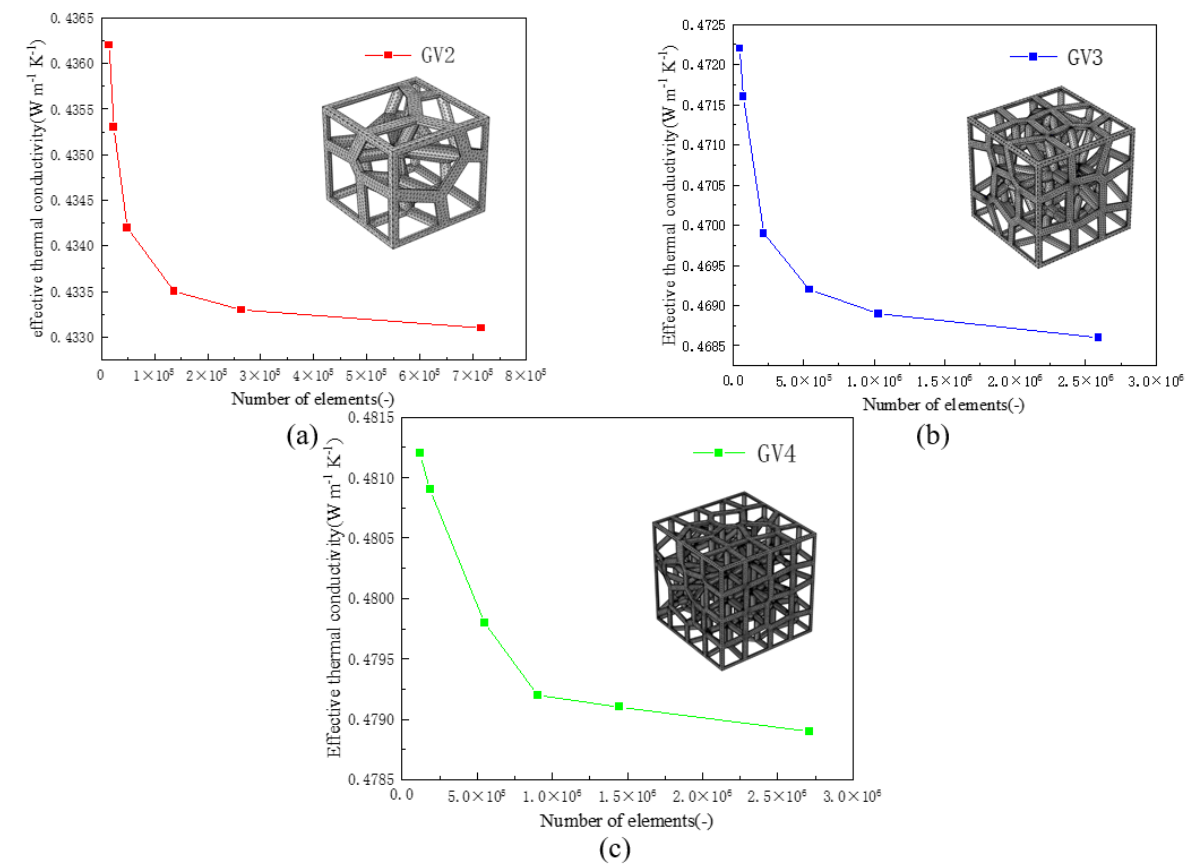
Figure 6. Results of mesh independence tests of three gradient structures with 86% porosity: ( a ) GV2; ( b ) GV3; ( c )